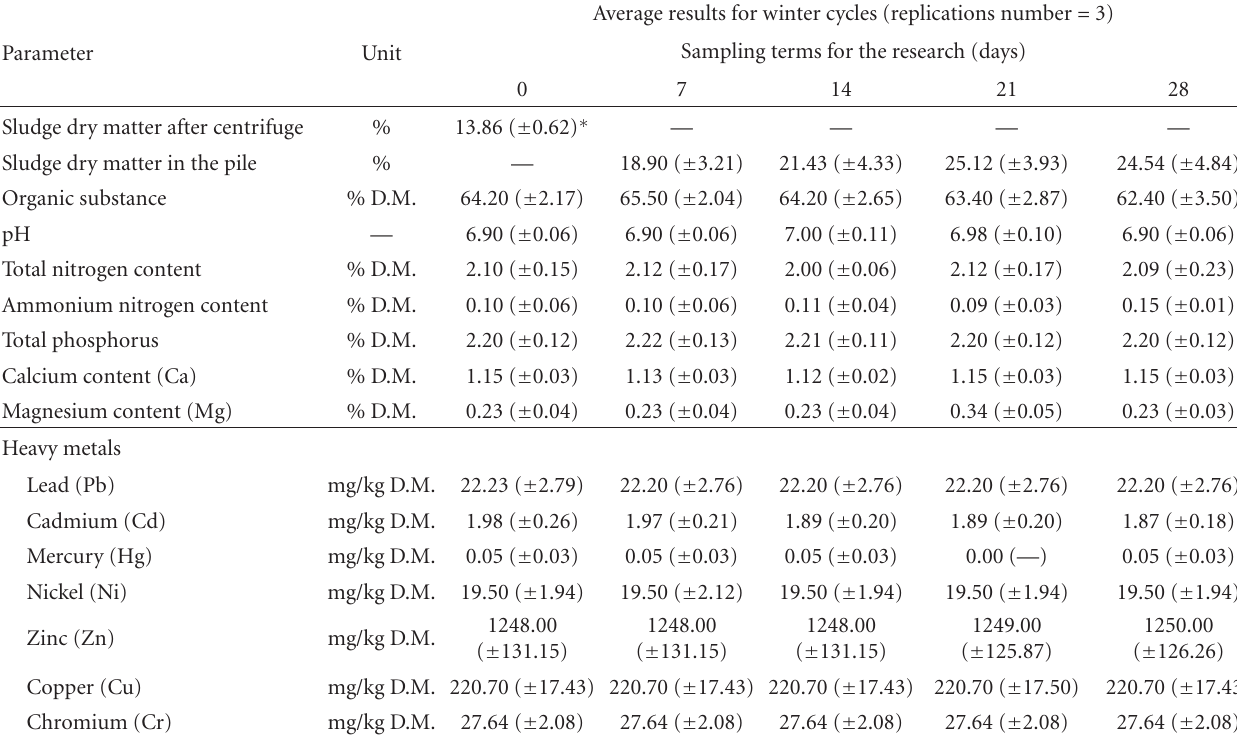
Table 3: Average results of physicochemical analyses of sewage sludge in winter cycles. Average results for winter cycles (replications number =